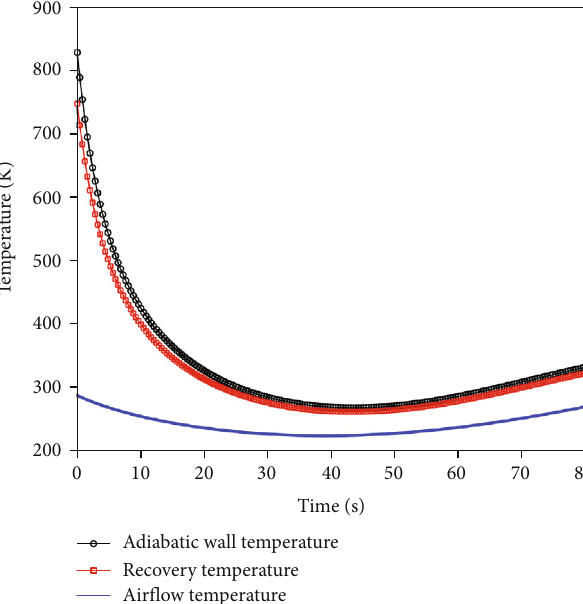
Figure 6: Average reference temperatures.